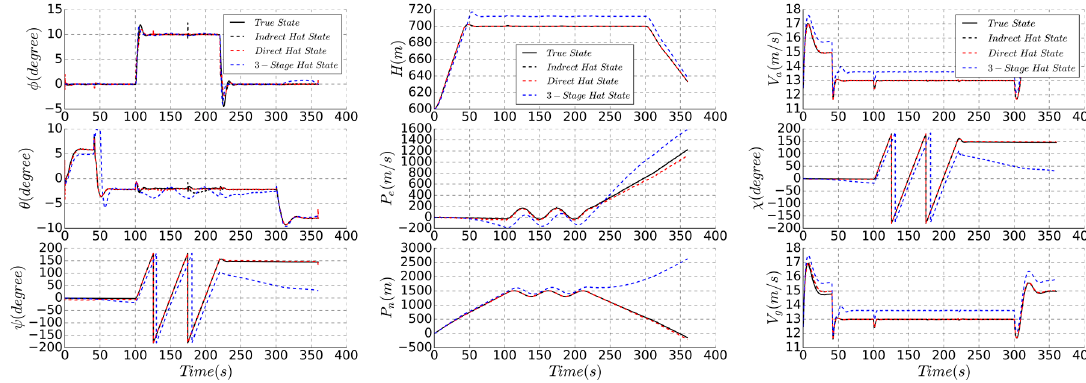
Figure 13. Different mission phases simulation.